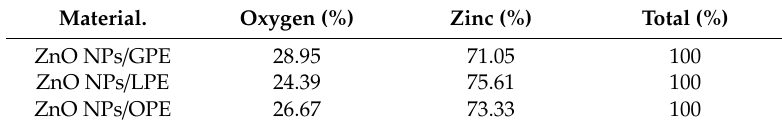
Table 1. The Elemental Composition of the synthesized CPE / ZnO